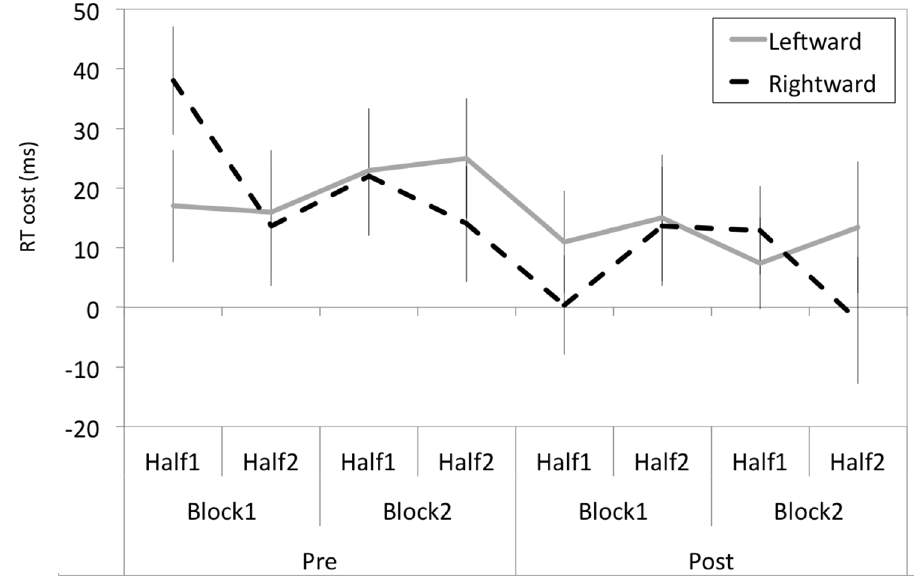
Figure 3. The RT costs of alignment for incongruent trials over time. The RT costs for the leftward- and rightward-shifting prism groups are shown broken into eight different time periods across the experiment, and were no different between the two